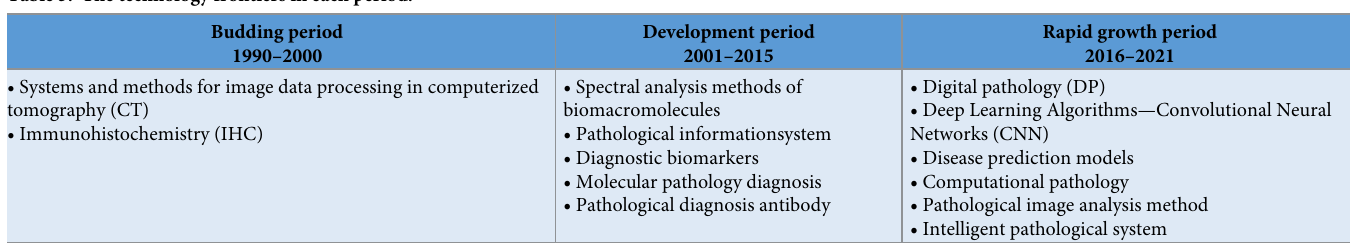
Table 5. The technology frontiers in each